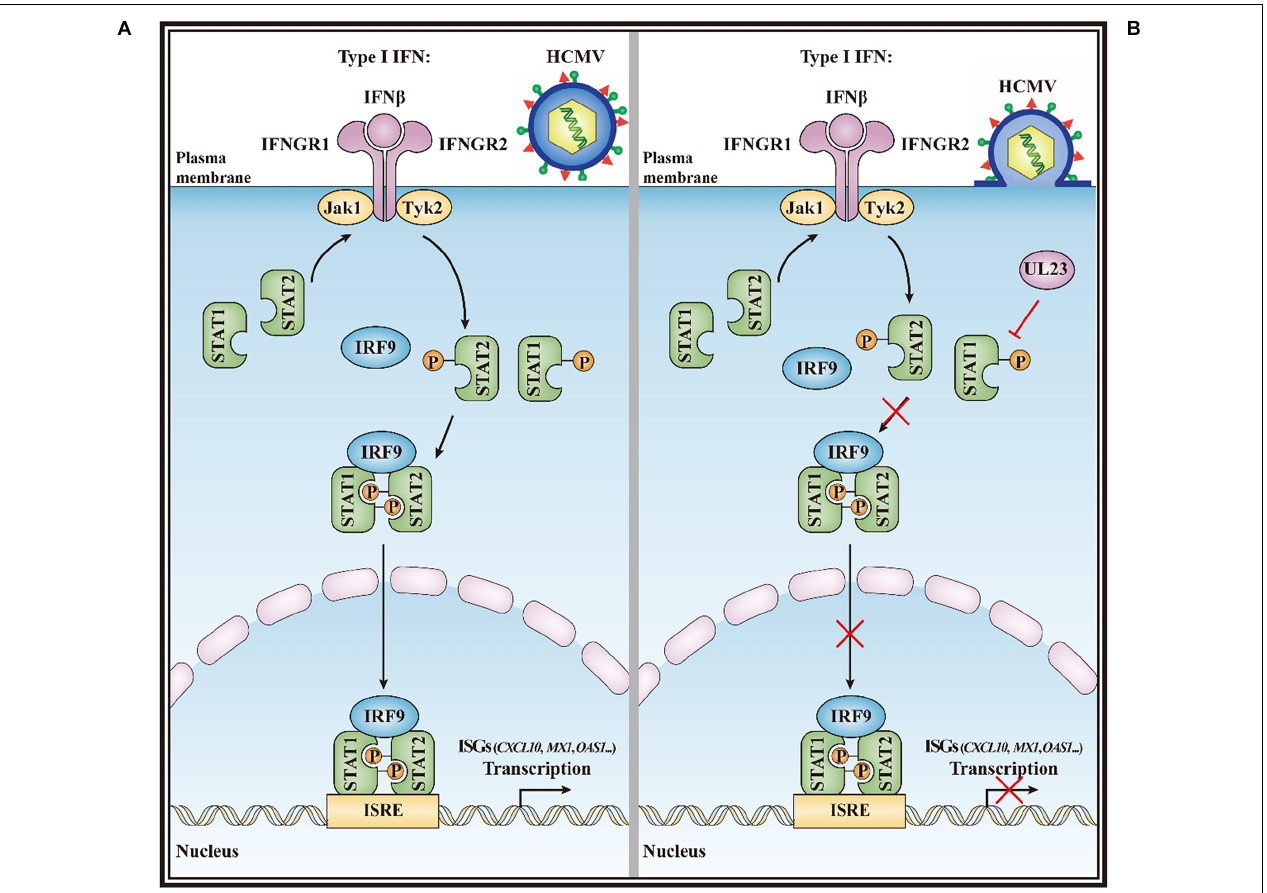
FIGURE 6 | A model for the HCMV UL23-mediated suppression of type I interferon response. (A) IFN-I can trigger Tyk2 and Jak1 by binding to IFNAR1 and IFNAR2, separately, after recognizing the cognate receptor (IFNAR1/2). In turn, Tyk2 and Jak1 contribute to the tyrosine phosphorylation of receptor chains (Y–P), thus creating docking sites for the phosphorylation of STAT1 and STAT2. Thereafter, IRF9, STAT1, and STAT2 form the ISGF3 transcriptional regulator. And ISGF3 translocate to the nucleus for promoting transcription by the ISRE regulatory sequence in ISGs (such as CXCL10 , MX1 , and OAS1 ). (B) During HCMV infection, UL23 disrupts the STAT1 phosphorylation and nuclear localization of STAT1 in type I interferon signaling; inactivation of STAT1 by UL23 blocks phosphorylated ISGF3, reduces ISG transcription and ISRE promoter activation, prevents type I interferon-induced responses, and facilitates viral immune escape from type I